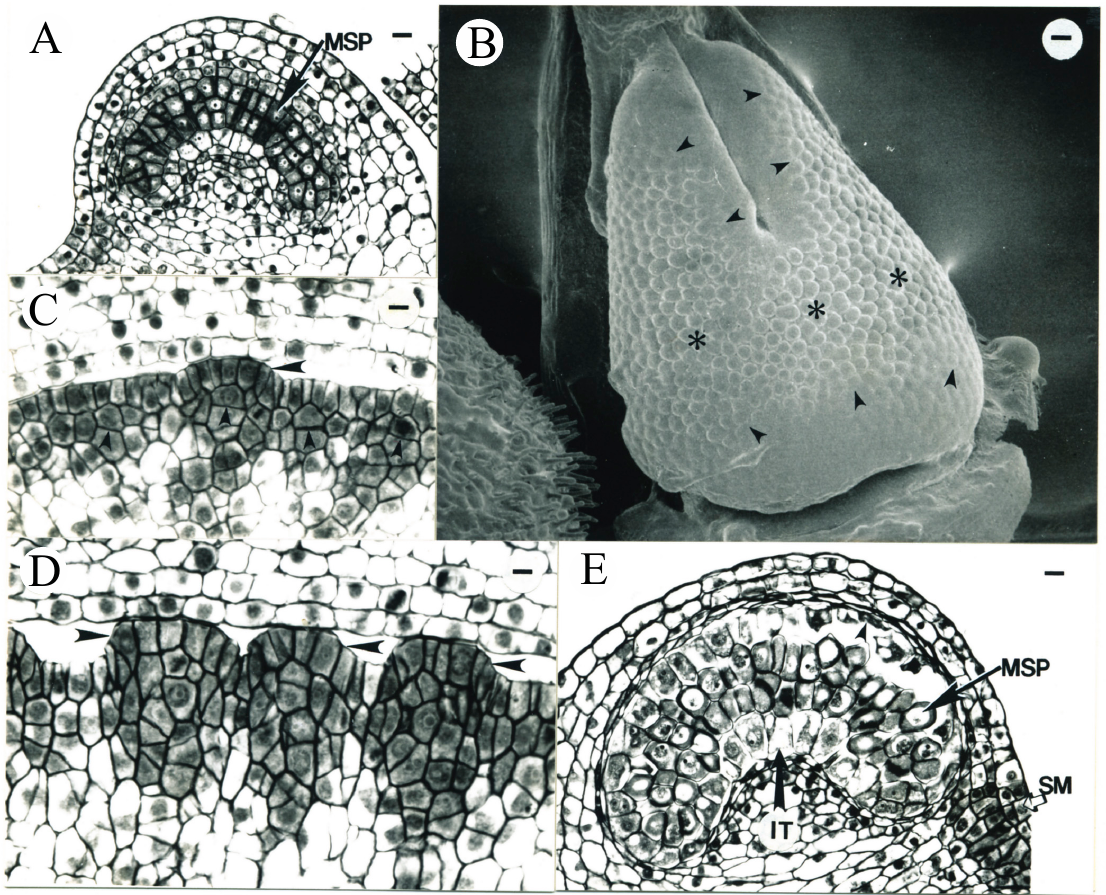
Figure 6. Tobacco anther development during the 9th day after ECP ( A ) and tobacco pistil and anther development during the 10th day after ECP ( B – E ). ( A ) Transverse section of a representative abaxial microsporangium from the age interval 8.9 ± 1.1 days after ECP. Cells in the sporogenous tissue are in prophase I of meiosis. MSP, microsporocyte. Bar = 17.3 µm. ( B ) SEM micrograph of ovules initiating in the placenta from the age interval 10.0 ± 0.5 days after ECP. Older ovule primordia are located in the middle portion of placenta (asterisks), while younger ones in the distal and the proximal regions on the placenta (arrowheads). Bar = 41 µ m. ( C ) One ovule primordium (larger arrowhead) similar to those seen in ( B ). Ovule initiation is closely associated with the periclinal division in L2 cells in placenta (smaller arrowheads). Bar = 8.2 µ m. ( D ) Three ovule primordia (arrowheads) similar to those seen in the middle portion of the placenta in ( B ) (asterisks). Bar = 9.7 µ m. ( E ) Transverse section of a representative abaxial microsporangium showing the microsporocytes (MSP) when the average flower age is 10.0 ± 0.5 days after ECP. Some outer tapetal cells begin to degrade (arrowhead). Periclinal divisions in the CCC cells below stomium are evident. IT, inner tapetum; SM, stomium. Bar = 18.2 µm.